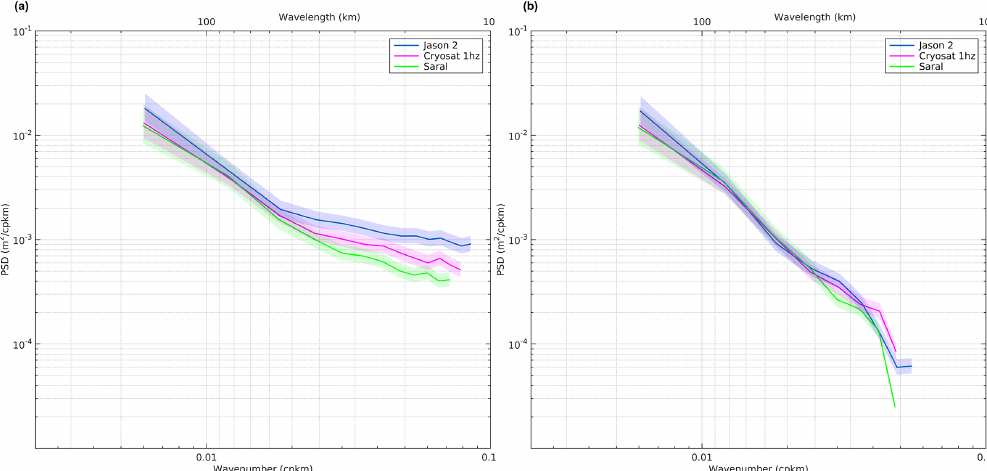
Figure 3. (a) Mean wavenumber spectra (power spectral density) for the three altimeter missions, averaged over the 200km track segments in the NW Mediterranean Sea, >50km from the coast, and for the common period 1 April 2013–30 April 2014. Jason-2 is in blue, SARAL in green, CryoSat-2 SAR 1Hz data in pink. (b) The unbiased spectra with a constant noise level removed, resulting in a mean k − 2 . 5 spectral slope. Shading represents the error bars, based on a chi-squared test with the number of degrees of freedom being wavenumber dependent. Table 1 gives the number of sections